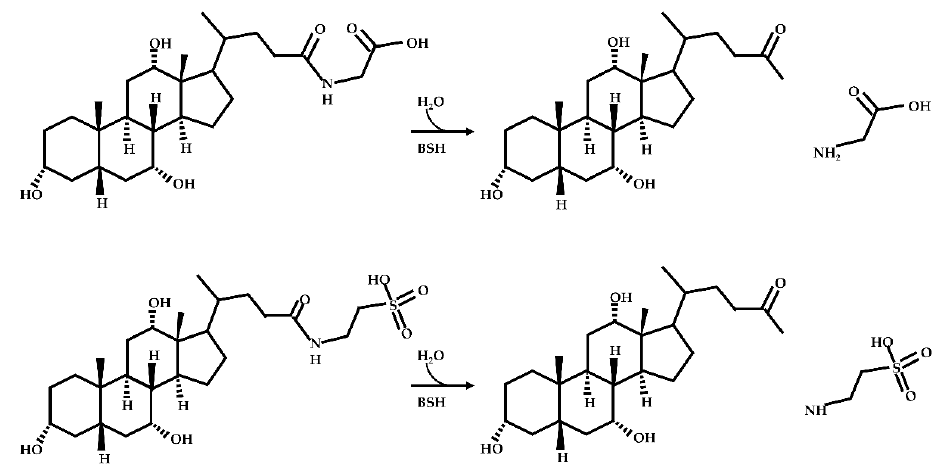
Figure 2. Deconjugation pathways of bile acids: Hydrolysis of conjugated bile acids to free bile acids and glycine or taurine by bile salt hydrolase (BSH).